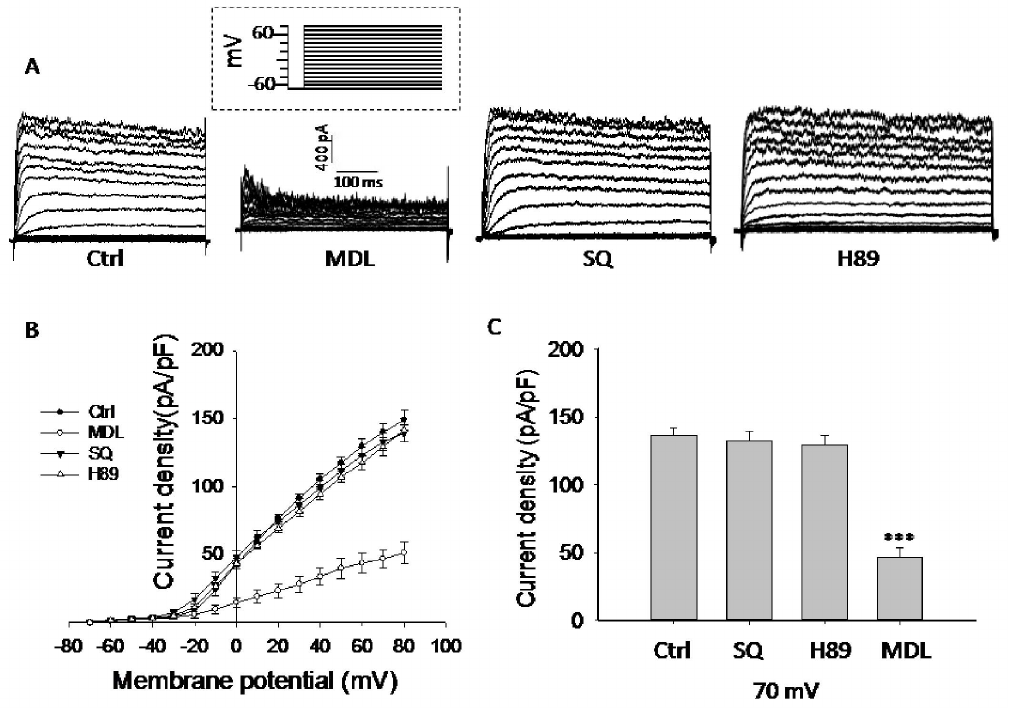
Figure 3. MDL-12,330A inhibits K V channels in pancreatic beta cells. K V currents were recorded in conventional whole-cell configuration from a holding potential of 2 70 mV to various depolarizing voltages ( 2 70 to 80 mV) as the protocol shown in inset. A. representative current traces recorded under the different treatments as indicated. B. current-voltage relationship curves of K V channels from rat beta cell. C. summary of the mean current density of K V channels recorded at 70 mV depolarization. Control (Ctrl, n=12); MDL-12,330A (MDL, 10 m M, n=6); SQ 22536 (SQ, 10 m M, n=7); H89 (1 m M, n=7). ***P , 0.001.